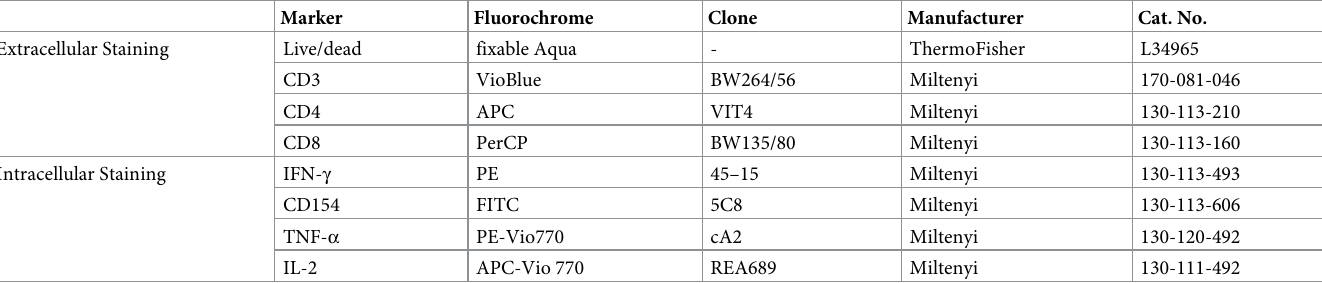
Table 2. Antibody clones used for FACS